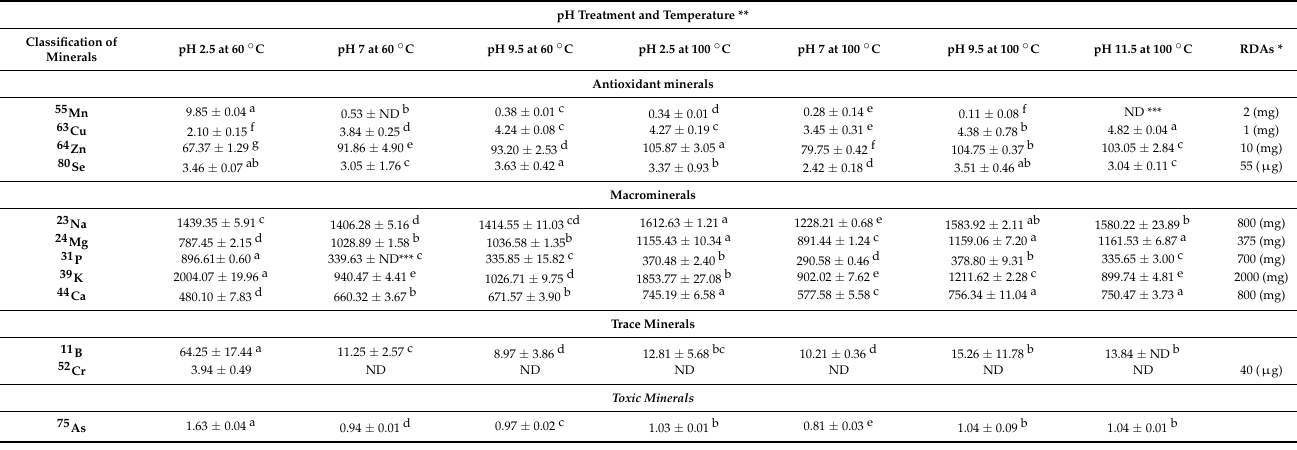
Table 1. Mineral content in Chaga ( Inonotus Obliquus ) extracts as a function of solvent pH and temperature under pressurized